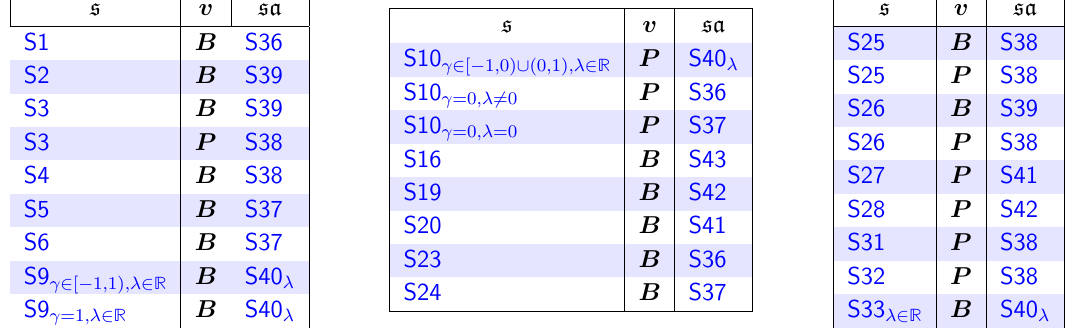
Table 13 . Correspondence between non-e(cid:11)ective super Lie pairs and aristotelian